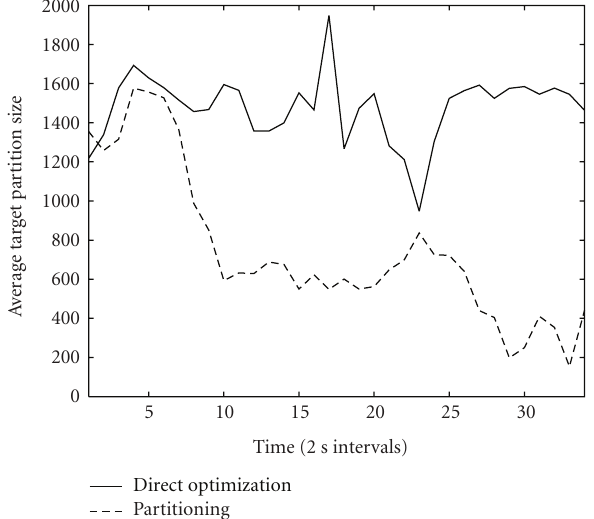
Figure 20: Comparison of sample mean number of targets localized over simulation time between state-of-the-art direct distribution optimization and partition learning classification path planning